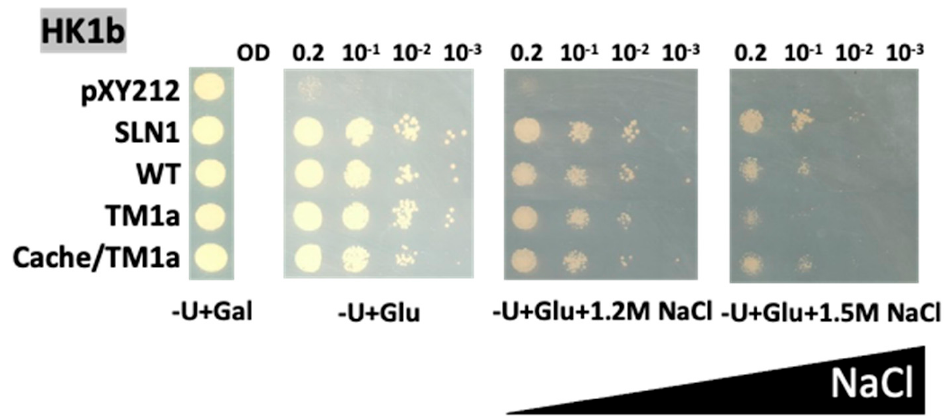
Figure 6. Functional complementation test for domain exchange mutants of HK1b on strong NaCl stress medium. The osmodeficient strain (MH179) was transformed with the negative (pYX212 empty vector) and positive (SLN1) controls, as well as with wild type constructs (WT) and single cache domain exchange constructs (cache1a residues 121–445), TM2 exchange constructs (TM1a with C478F mutation) or double exchange constructs of HK1b (cache/TM1a). Transformants were spotted onto galactose containing medium ( − U + Gal) for growth control and onto glucose containing medium ( − U + Glu), with increasing NaCl concentrations (1.2 and 1.5 M), for osmotic tolerance test. Growth tests are representative of three independent replicates as serial 10-fold dilutions from an OD 600 = 0.2, as indicated.